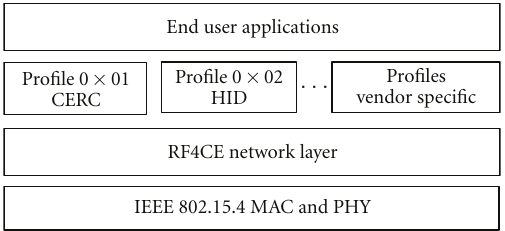
Figure 1: RF4CE protocol